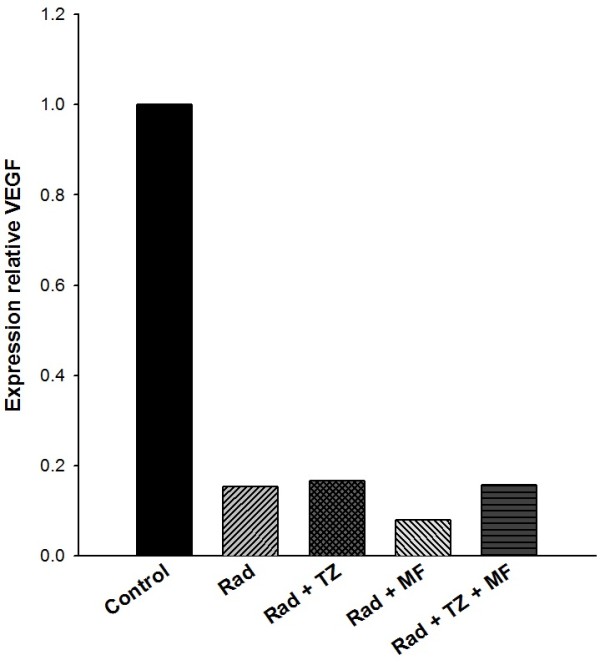
Quantitative Real-Time PCR analysis of VEGF relative expression in C6 xenografts after each treatment. Analysis was done on whole lysates from tumors removed on day 25.